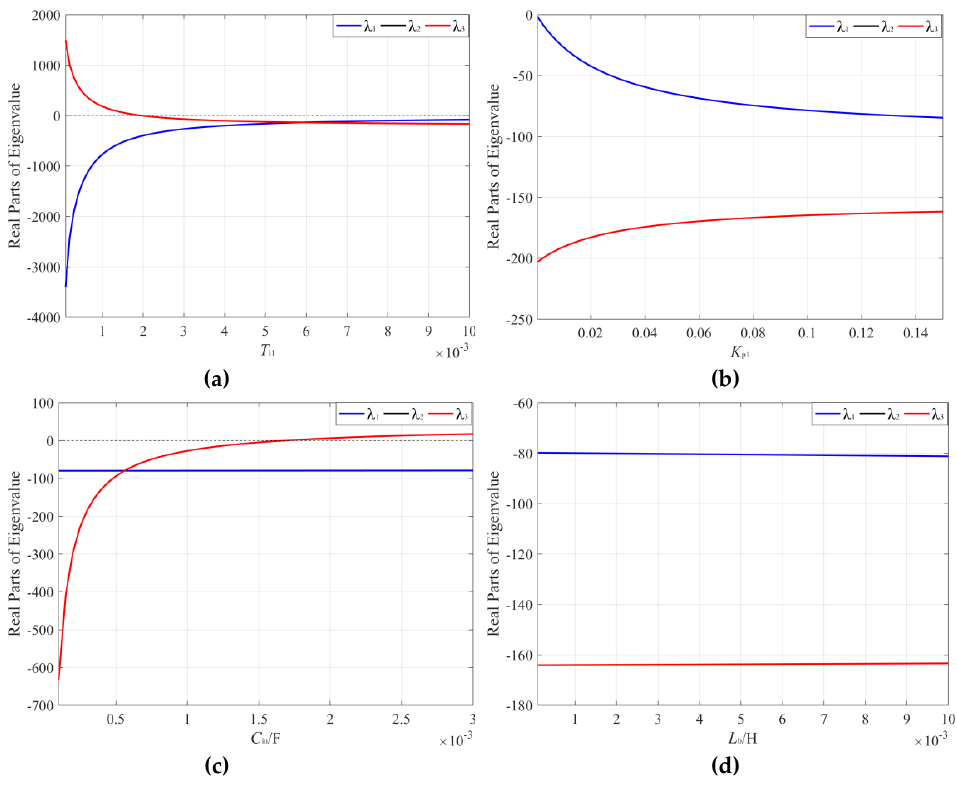
Figure 5. Trajectory of the real part of λ 1 , λ 2 , λ 3 as the changing of ( a ) T i 1 ; ( b ) K p 1 ; ( c ) C in ; ( d ) L b. Table 4. Relative eigenvalue sensitivity of di ff erent parameters in SS.